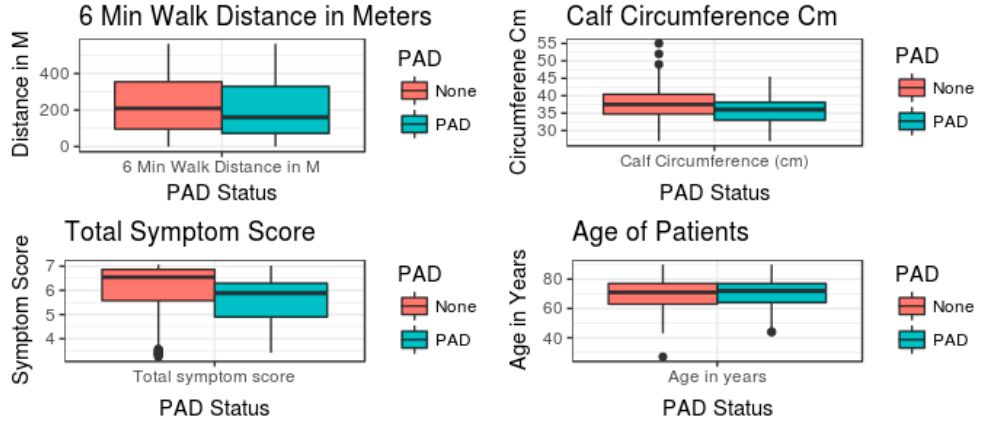
Figure 4. Mean ± SE of the predictor variables between no PAD and PAD.